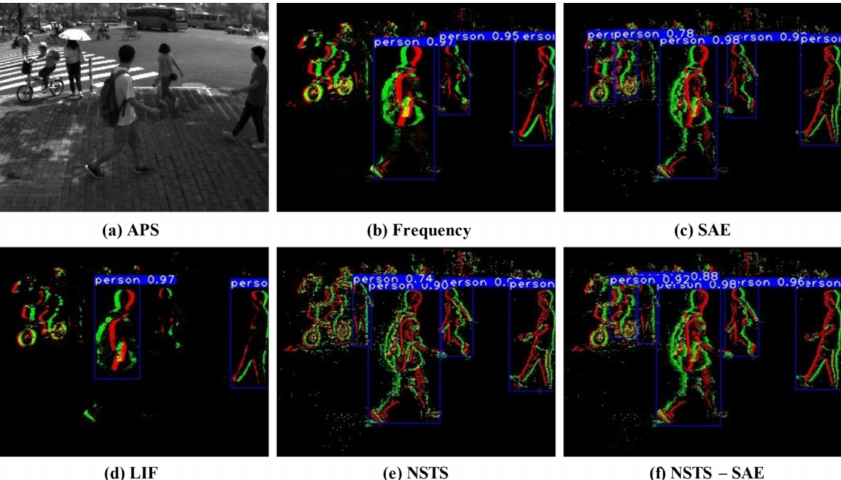
Figure 5. Detection results of different event frame encoding methods in EBD (event-based detector). The blue boxes in each figure mark the corresponding predicted object position. ( a ) APS (active pixel sensor) channel from DAVIS camera (used to display real-world scenario); ( b ) frequency [10]; ( c ) SAE (surface of active events) [15]; ( d ) LIF (leaky integrate-and-fire) [18]; ( e ) NSTS (neighborhood suppression time surface); ( f )